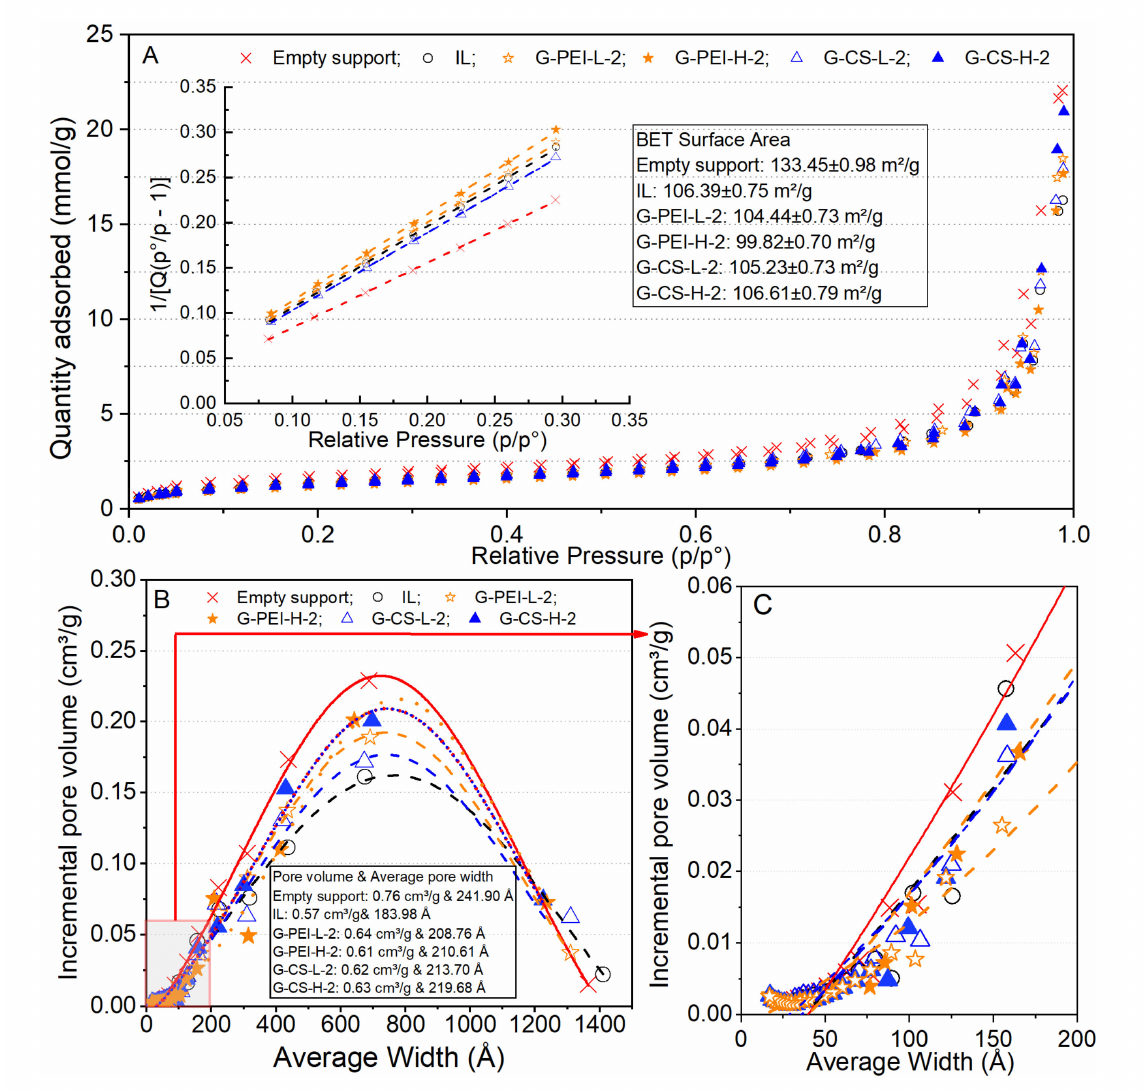
Figure 5. BET full nitrogen adsorption isotherm ( A ), where the BET plot is shown in the inset; pore size distribution curve ( B ); graph showing that the distribution of pore sizes smaller than 200 Å was enlarged ( C